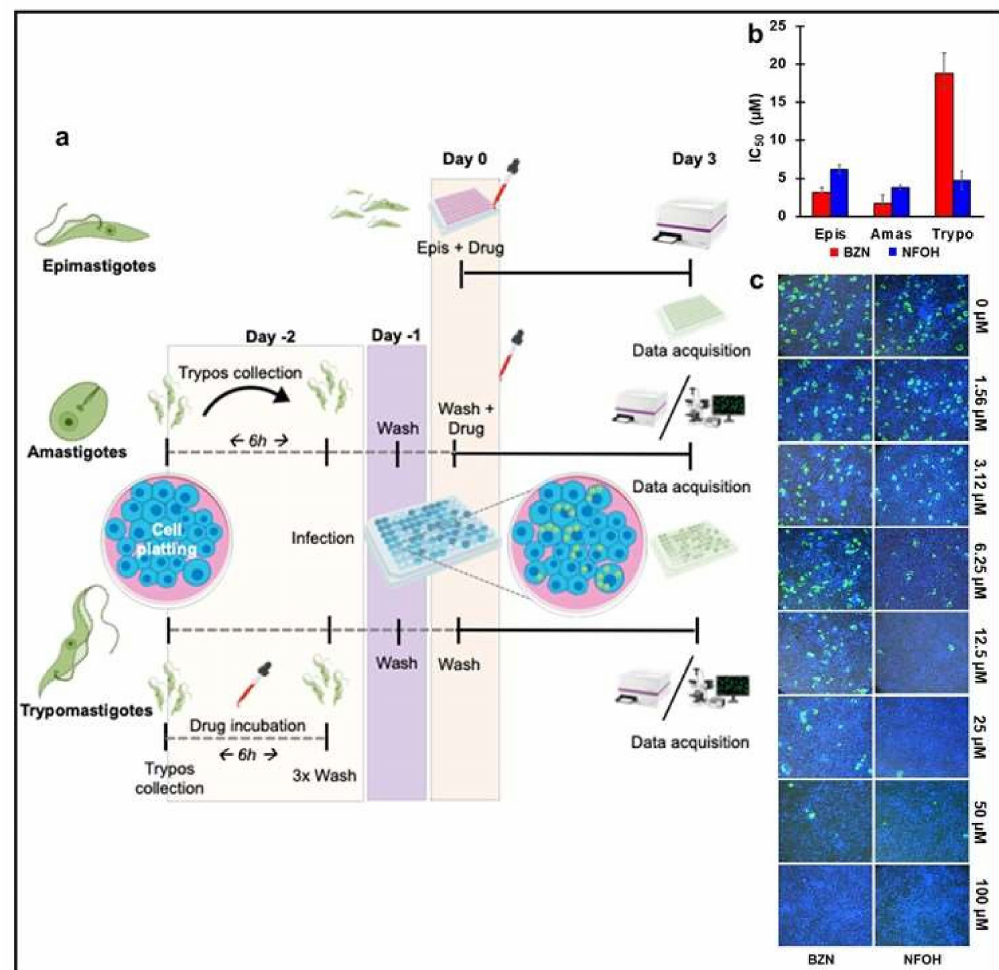
Figure 1. In vitro screening assays using bioluminescent:fluorescent T. cruzi ( a ) Schematic view of the screening protocols for measuring drug activity against epimastigote, amastigote and trypomastigote forms using T. cruzi CL-Luc::Neon [30]. ( b ) Drug activity against the three developmental forms of T. cruzi . The y axis indicates the IC 50 values ( µ M) (see Materials and Methods for assay conditions). Values represent 3 individual replicates, and are the mean ± SD. ( c ) Image analysis of broad-field (4 × captures from live fluorescent microscopy at the end-point of the trypomastigote screening assay, showing representatives of 30 separate images per treatment. Blue = Hoechst stain (1:10,000 added 2 h before imaging), Green = mNeonGreen fluorescent